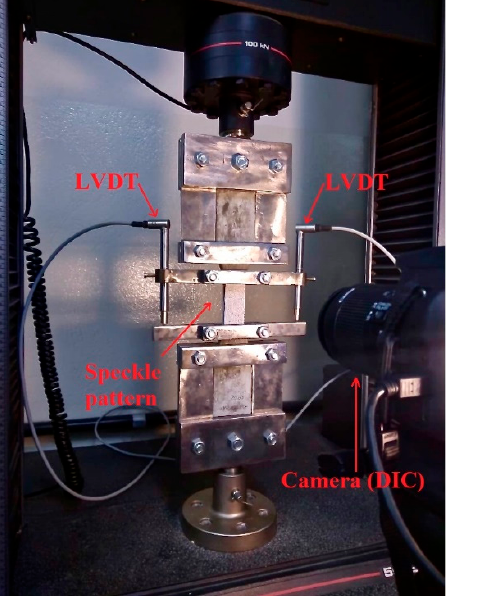
Figure 3. Autogenous shrinkage test: ( a ) test setup scheme and ( b ) on going test. 164